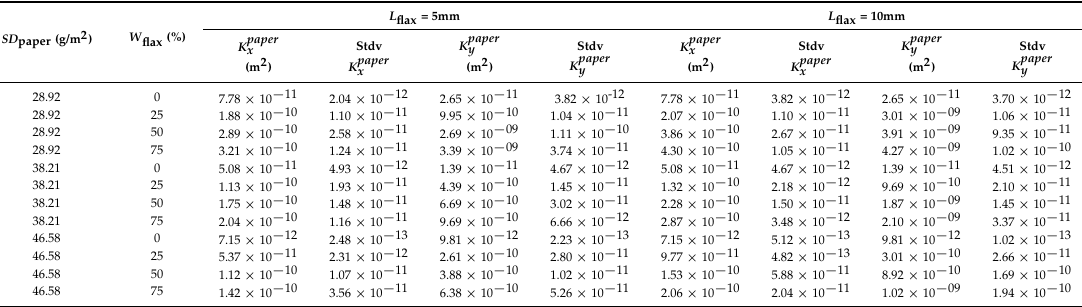
Table 3. Results of planar permeability of paper layers.